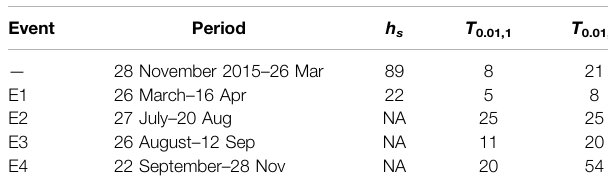
TABLE 6 | The number of days ofsnow cover, during selected events, at the sites of the sonic ranger ( h s ), Pit 1 ( T 0.01,1 ) and Pit 2 ( T 0.01,2 ). The events E1 - E4 are highlighted in Figure 8